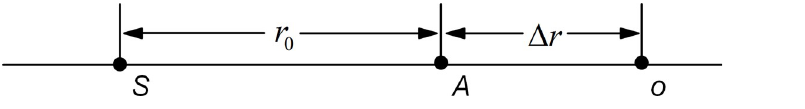
Fig 2. Schematic diagram of the source and observation